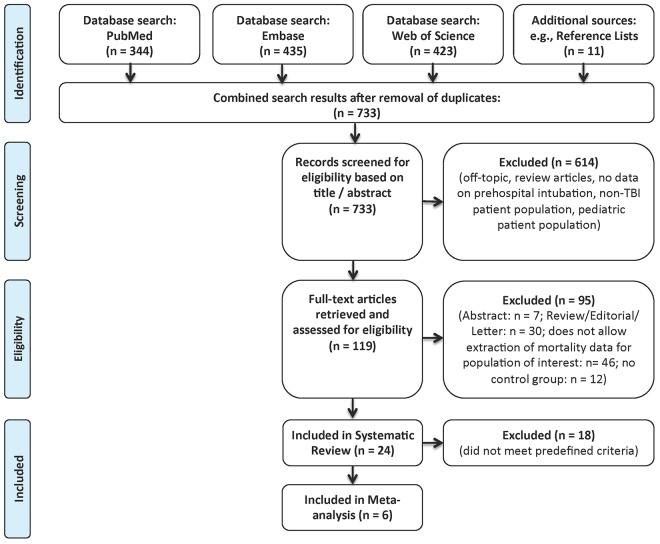
PRISMA flow diagram.PRISMA flow diagram summarizing identification, screening, eligibility and inclusion of studies.